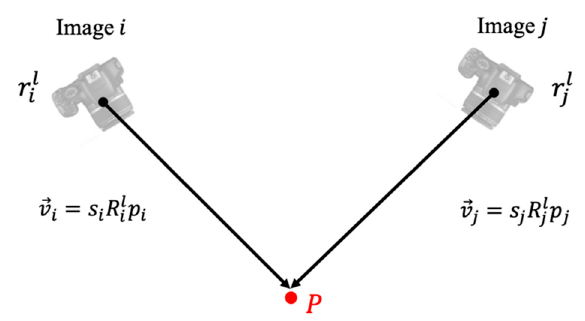
Figure 9. The established conjugate point constraint for global translation averaging.